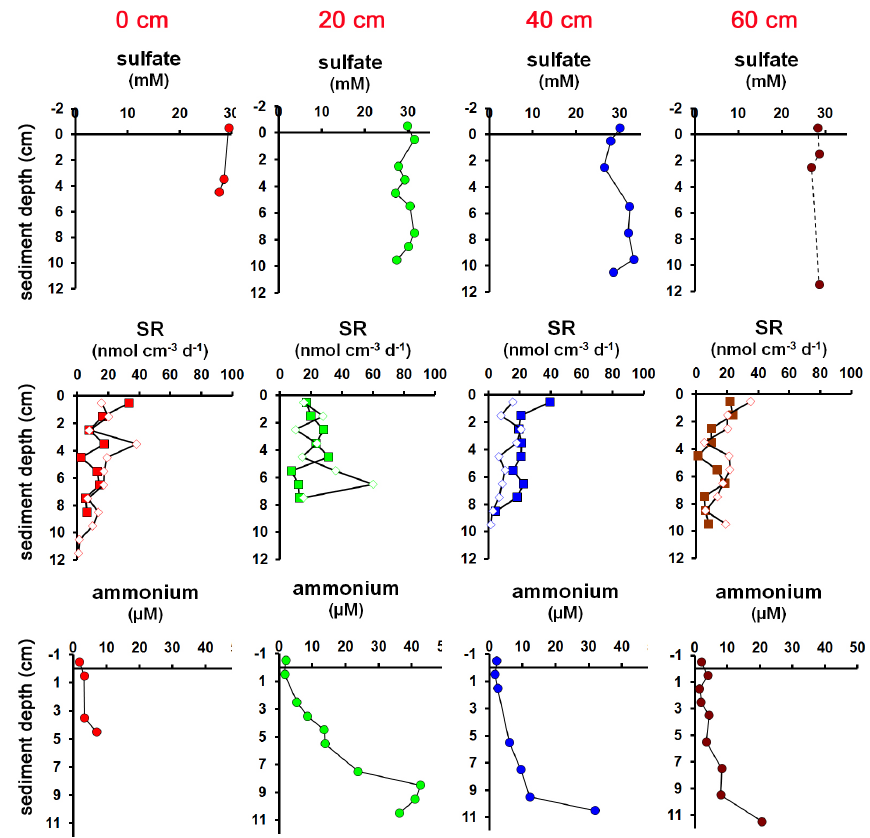
Fig. 2c. Biogeochemical profiles of the November sampling (transect) at Brian Seep: sulfate, sulfate reduction (SR, 2 replicates), and ammonium. At 60cm, the sulfate profile is dashed, because of low reliability given by the limited amount of data points over depth. Distances from gas vent: 0 (red), 20 (green), 40 (blue), and 60cm